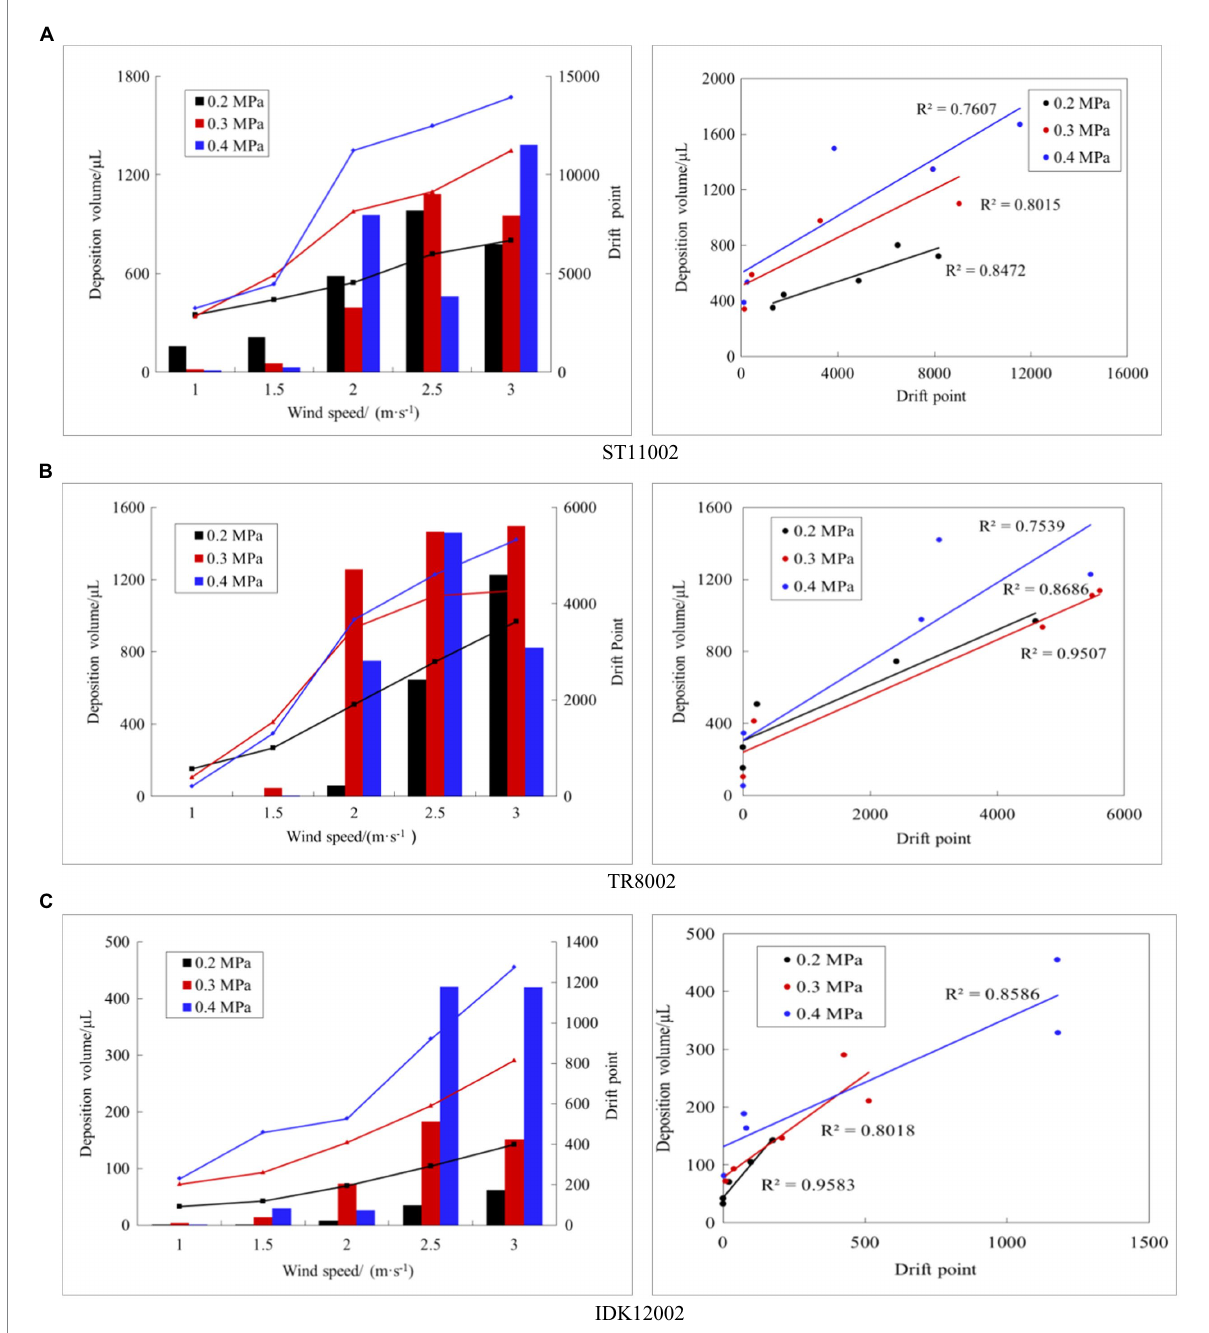
FIGURE 7 Correlation analysis of drift points and deposition volume for the three nozzles. The left panel shows the drift points and deposition under various working conditions (line represents deposition volume, column represents drift points), and the right panel shows the correlation between the two methods. (A) ST11002. (B) TR8002. (C)